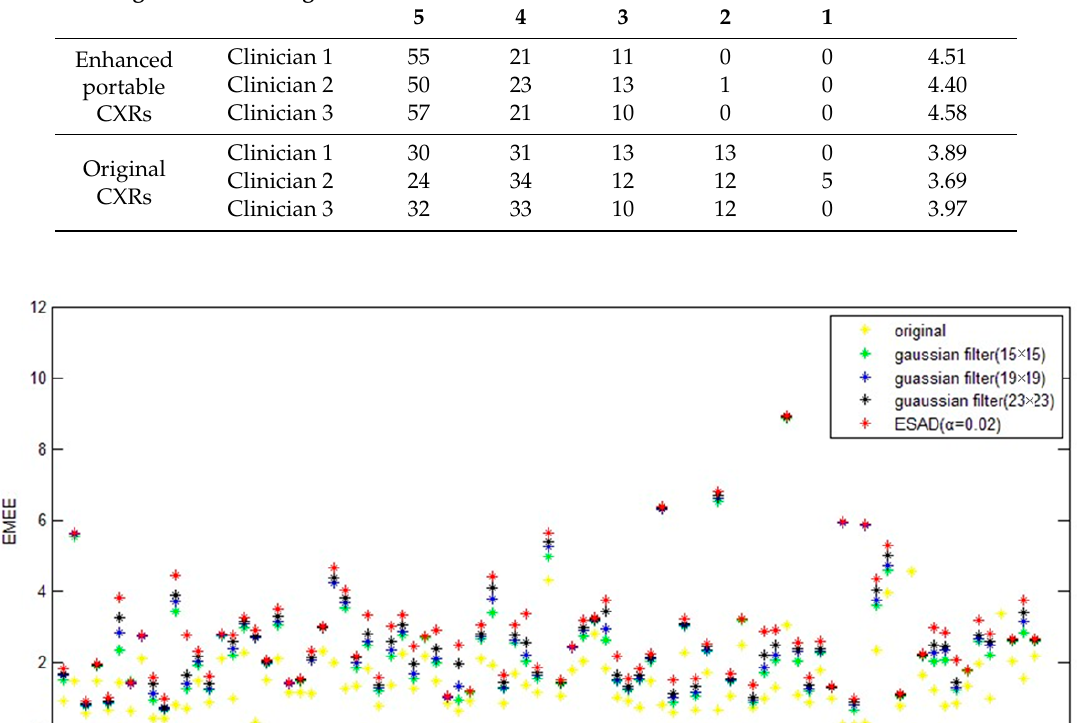
Table 1. The evaluation result.